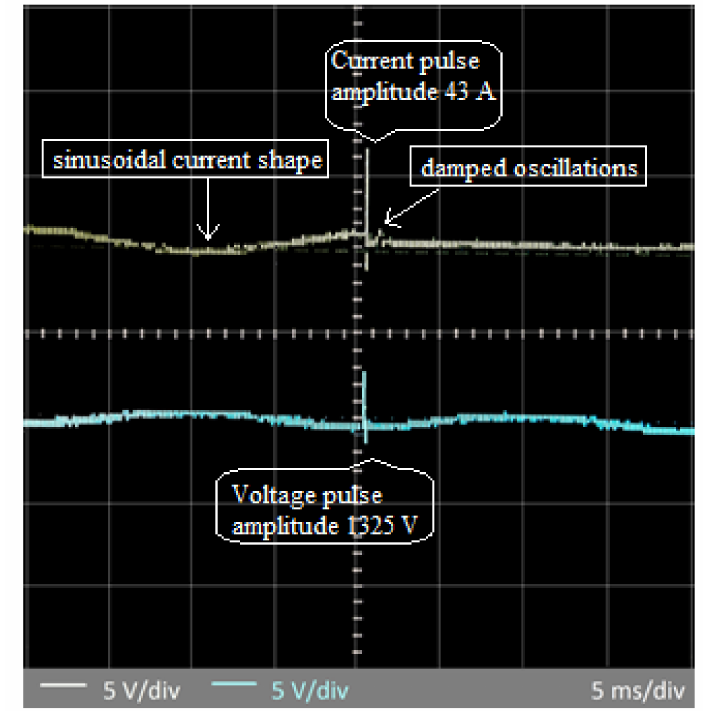
Figure 16. Current (yellow) and voltage (blue) waveform in a photovoltaic system disturbed by a 1.2/50 µ s voltage surge with positive polarization.